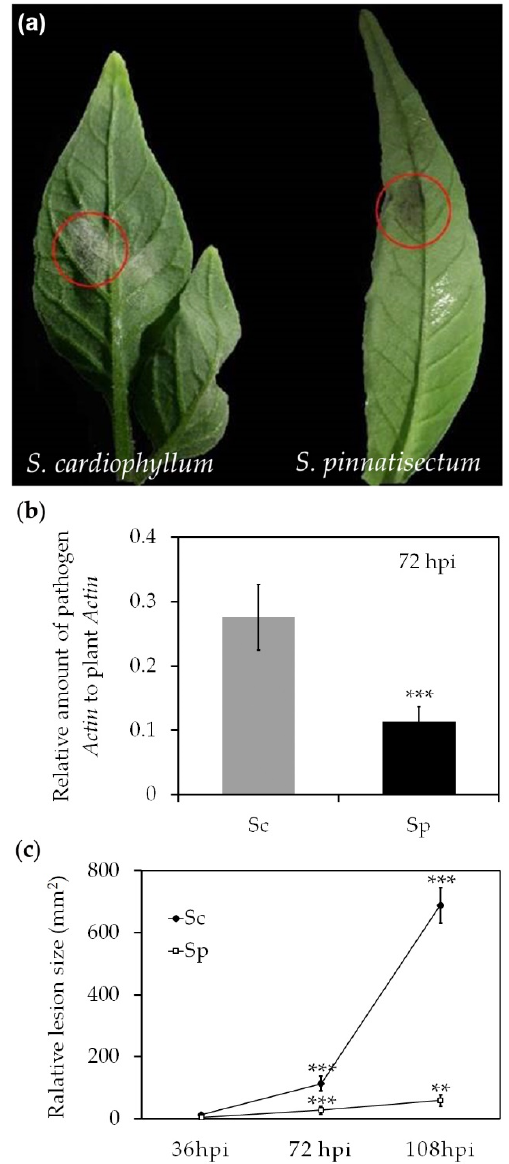
Figure 1. Infection of Solanum pinnatisectum and Solanum cardiophyllum by Phytophthora infestans . ( a ) The symptom on S. cardiophyllum and S. pinnatisectum 72 h post-inoculation (hpi). ( b ) The biomass of P. infestans detected in S. pinnatisectum and S. cardiophyllum 72 hpi. Each error bar represents the mean ± SD. ( c ) The lesion size on S. pinnatisectum and S. cardiophyllum measured at different times post inoculation. Sc: S. cardiophyllum , Sp: S. pinnatisectum . (Each error bar represents the mean ± SD, **